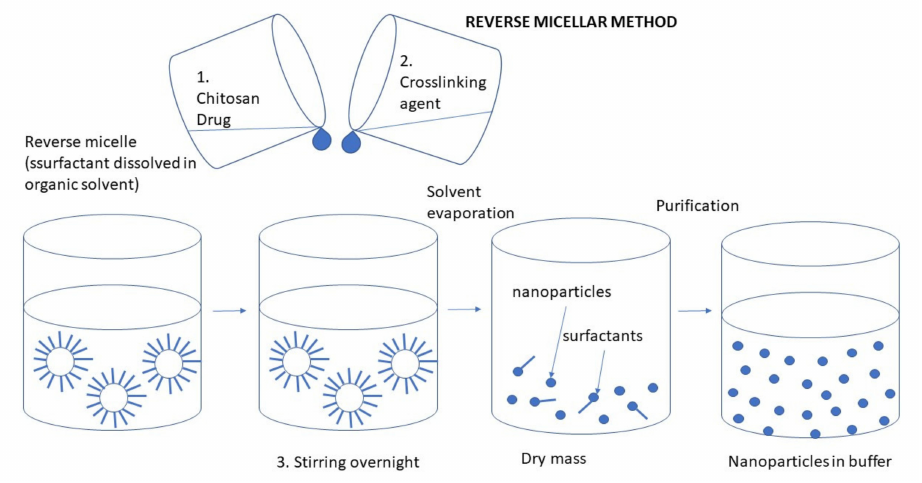
Figure 8. Preparation of CS NPs by the reverse micellar